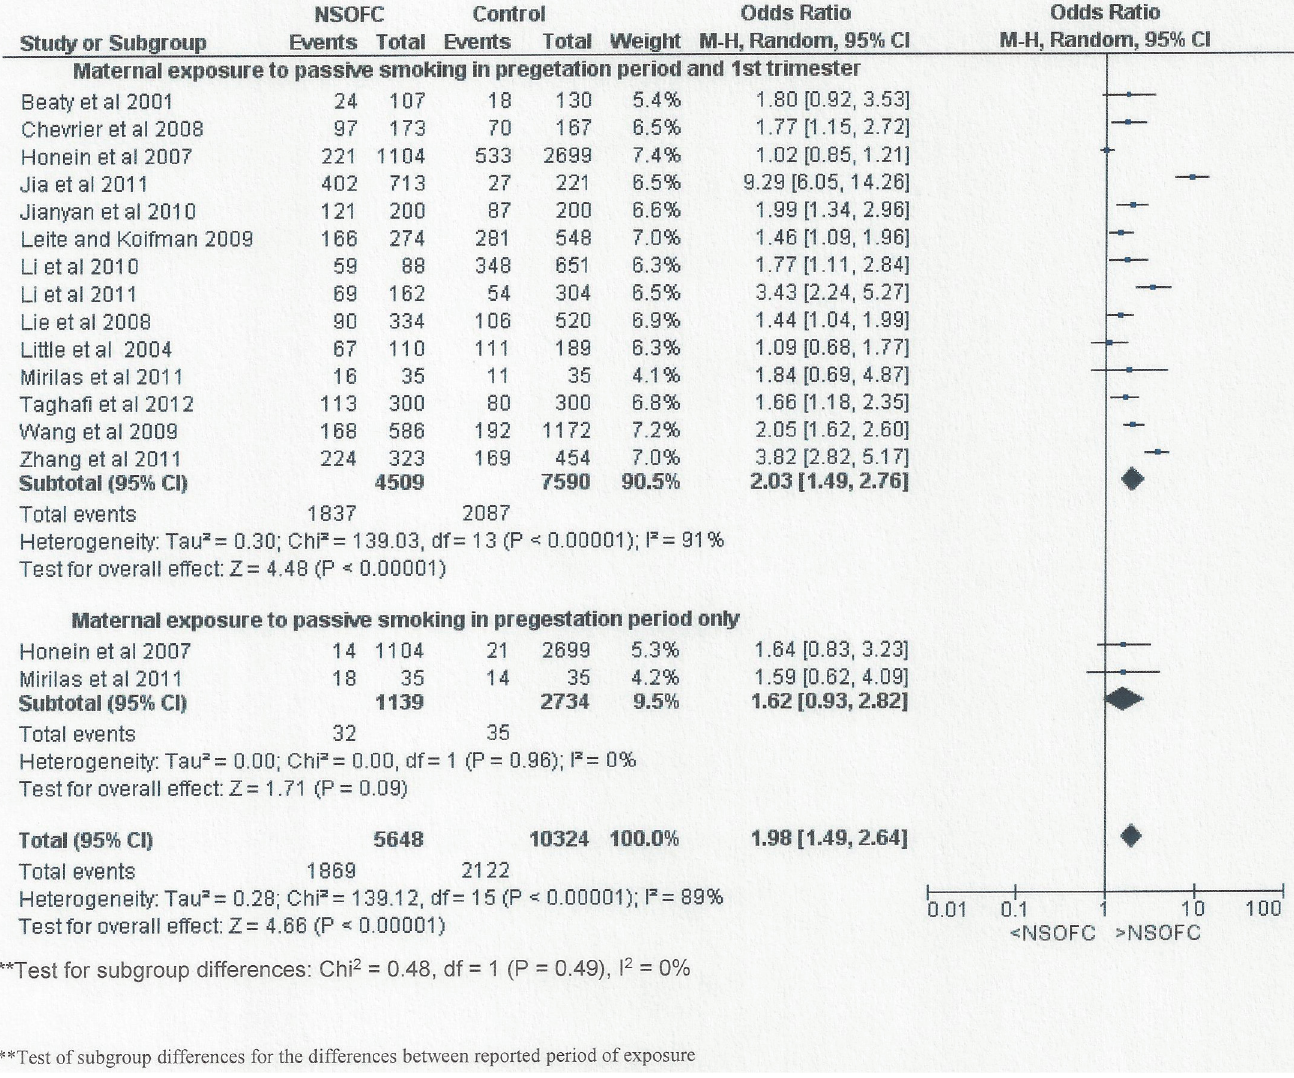
Fig 5. Forest plot for meta-analysis of the association between NSOFC and maternal passive smoking exposure in the 1st trimester including or not including the pregestation period compared to maternal exposure prior to pregnancy period